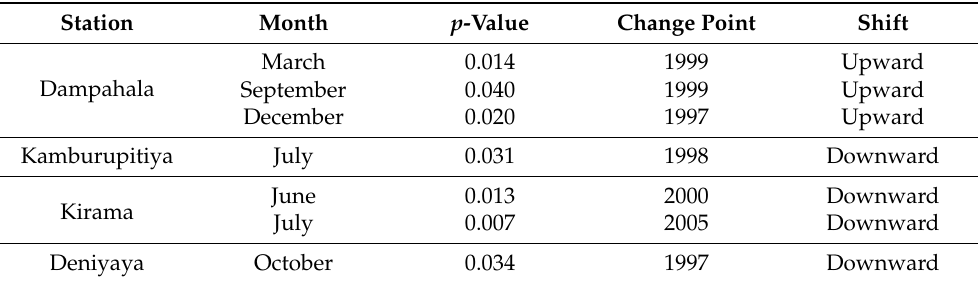
Table 8. Pettitt’s test results of monthly rainfall